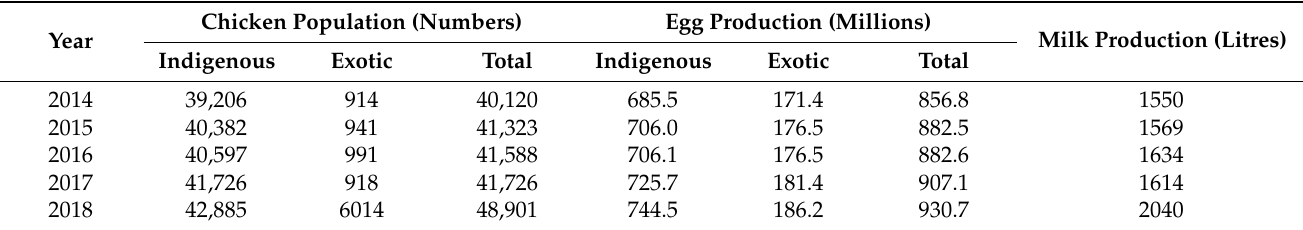
Milk Production (Litres)